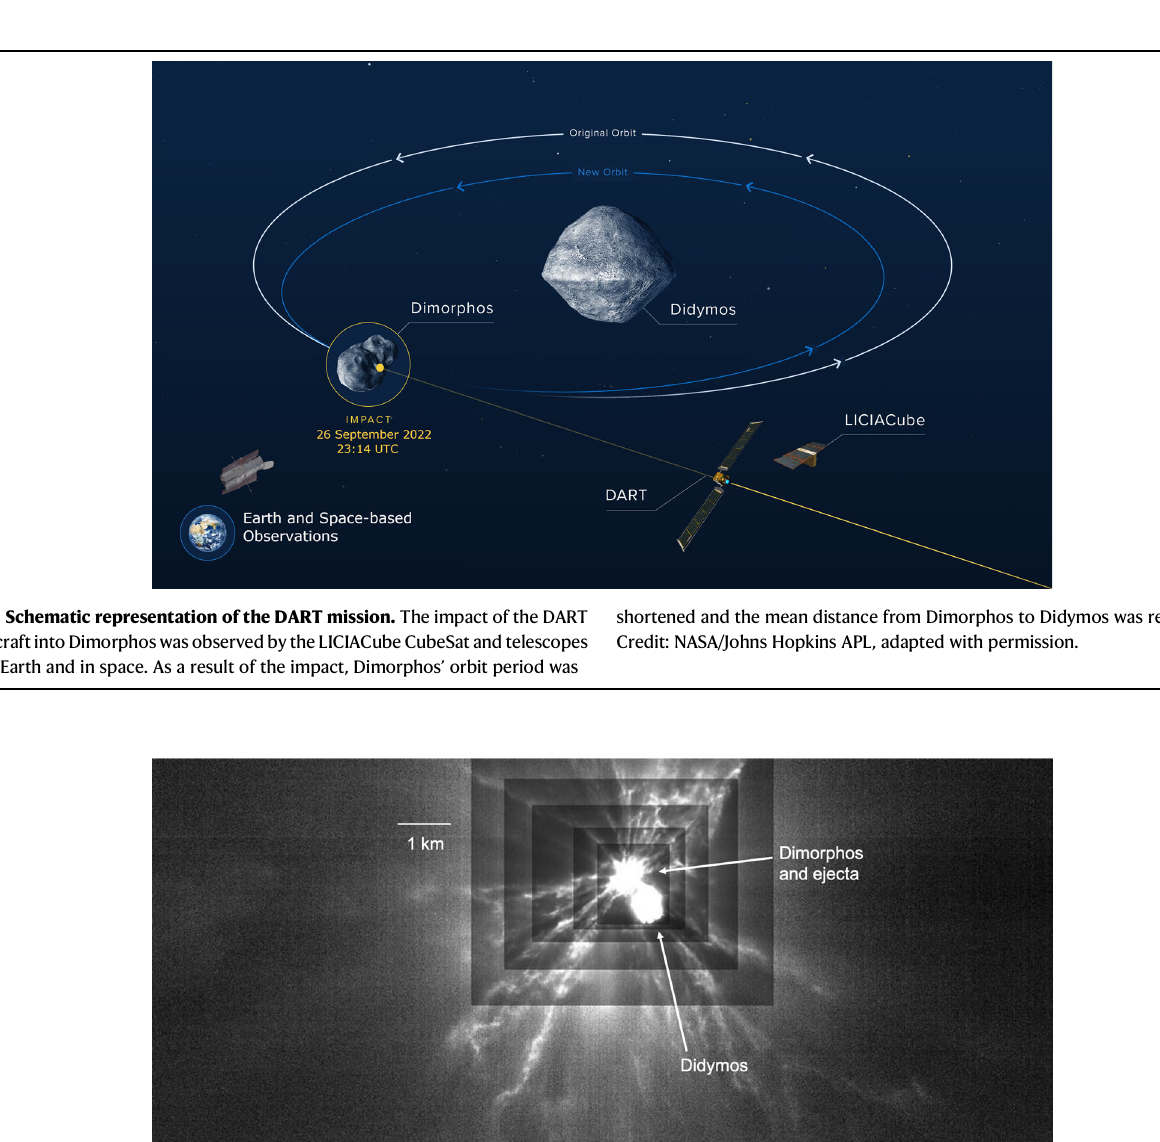
Fig. 2 | LICIACube image of the Didymos system after the DART impact. Fila- ments of ejecta are visible streaming away from the impact on Dimorphos. The contrast has been stretched in a differential manner across the image to make ejecta across the frame appear to be at the same brightness. The contrast is